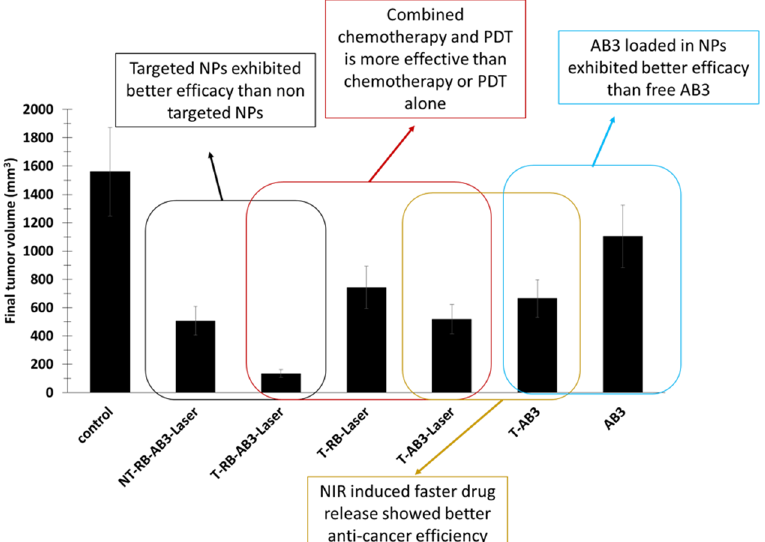
Figure 12. Final tumor volumes, demonstrating the in vivo anti-cancer PDT efficacy of different formulations of UCNP-based theranostic micelles in NET xenografts. Tumor-bearing mice were treated in seven groups: (1) saline (control); (2) AB3 (conventional chemotherapy); (3) T-RB-Laser (targeted NIR-controlled PDT); (4) T-AB3 (targeted chemotherapy); (5) T-AB3-Laser (targeted NIR- controlled chemotherapy); (6) NT-AB3-RB (nontargeted chemotherapy; no PDT effect as no laser illumination); (7) NT-AB3-RB-Laser (nontargeted combination NIR-controlled chemotherapy and PDT). Each mouse received two intravenous injections (30 mg/kg of AB3) over a 7-day interval. A continuous wave fiber-coupled 980 nm laser (0.5 W / cm 2 , 15 min, 1 min interval after every 5 min of irradiation) was applied at the tumor sites in the “Laser” groups 4 h post injection. Adapted from Chen et al. [28] .